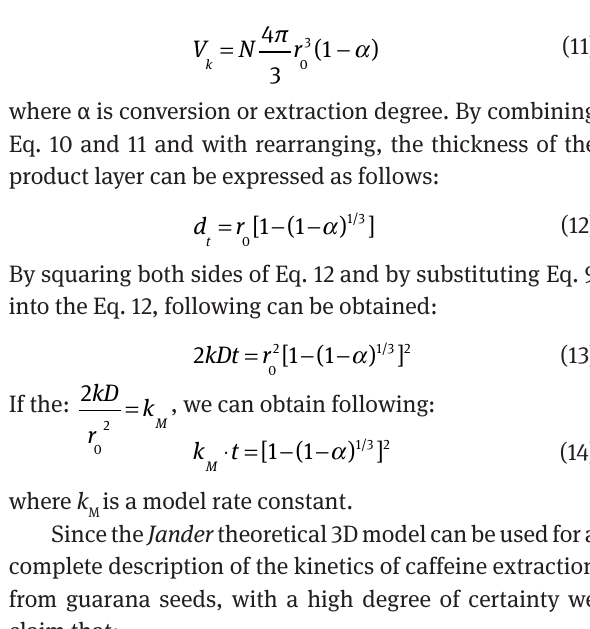
Figure 5: The dependence of ln (d α /d t ) α on T -1 (K -1 ).